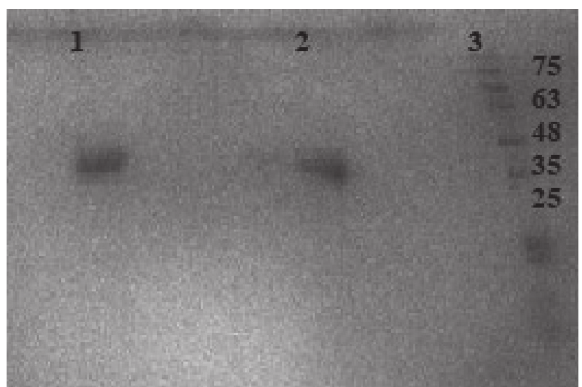
Figure 6: SDS-PAGE illustrates the presence of purified lipase enzyme. Lane 1 shows the ammonium sulphate precipitated, lane 2 illustrates the lipase obtained after purification, and lane 3 lipase shows the position of molecular markers